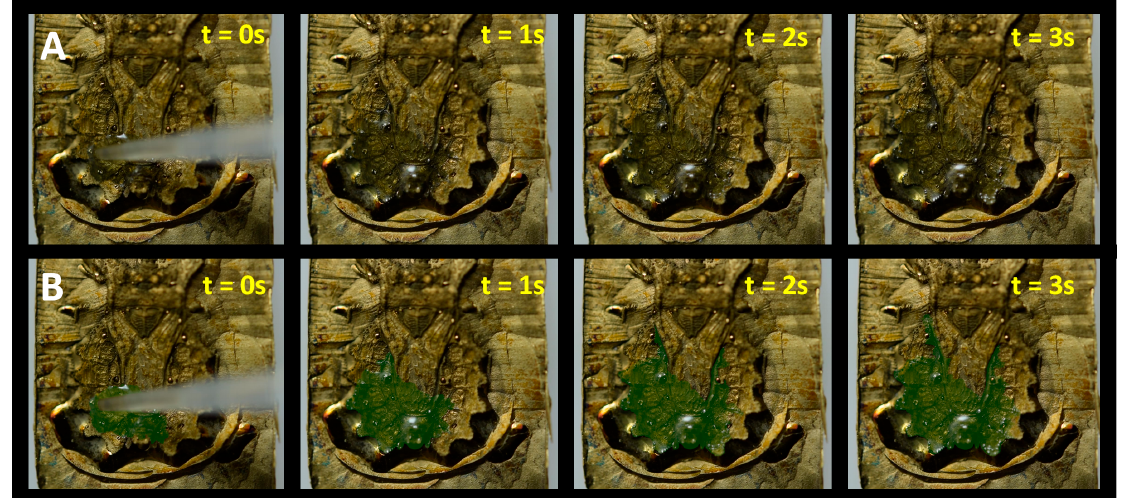
Figure 7. Oil spread on the dorsal surface of an all-metal replicated flat bug. ( A , B ) Frames from Supplementary Video S1 (seconds 12–16) show spread of oil on the replica surface. Oil is colorized in ( B ) for contrast and better visualization.